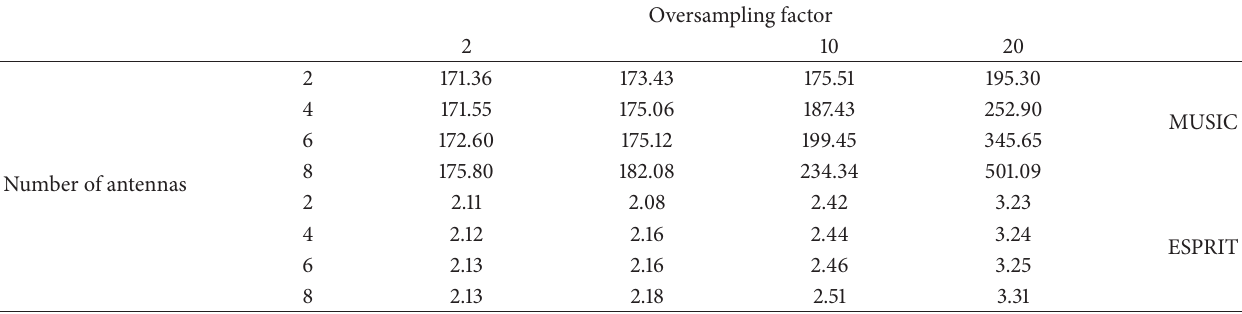
Table 9: Number of seconds to compute a geolocation estimate as a function of oversampling rate and number of antennas used in each